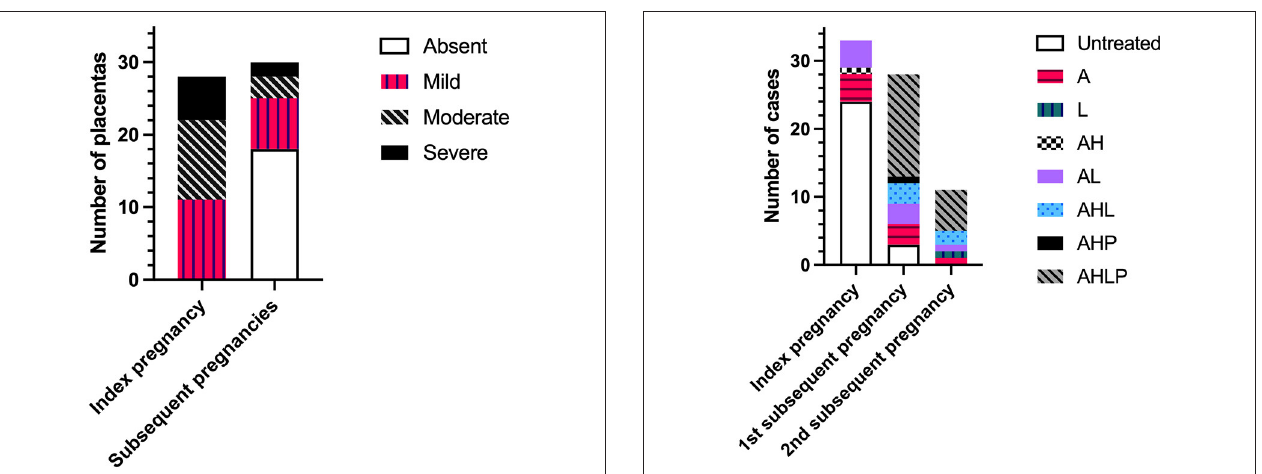
of pregnancies included in the study ( p = 0.11).